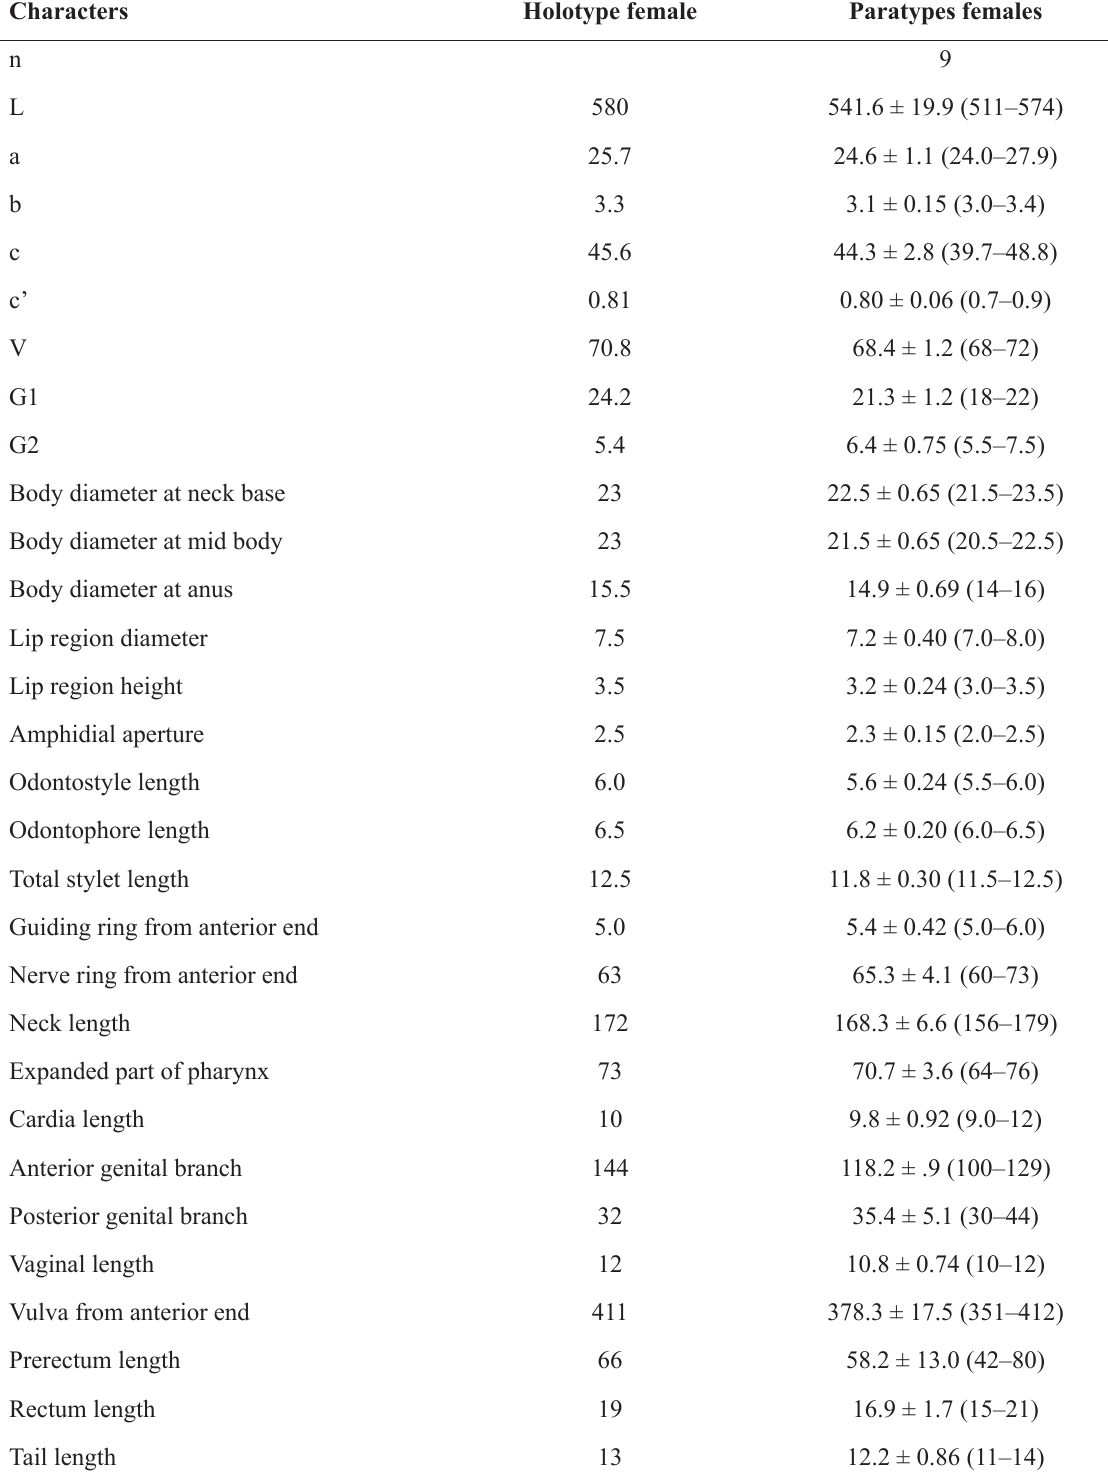
Table 10. Measurements of Tylencholaimus tamiliensis sp. nov. All measurements are in µm and in the form: mean ± s.d.